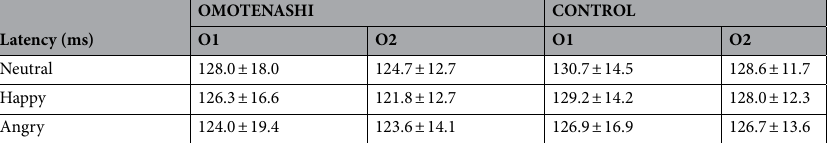
Table 2. Peak latency of P100 at O1 (left) and O2 (right) for Neutral, Happy, and Angry stimulus conditions in OMOTENASHI and CONTROL. Data are presented as the mean and standard deviation for each